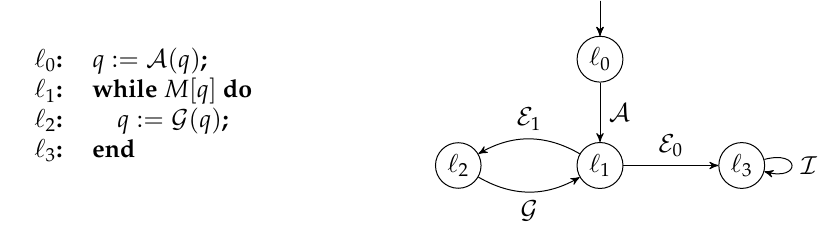
Figure 1. A simple loop program and its model as a quantum Markov